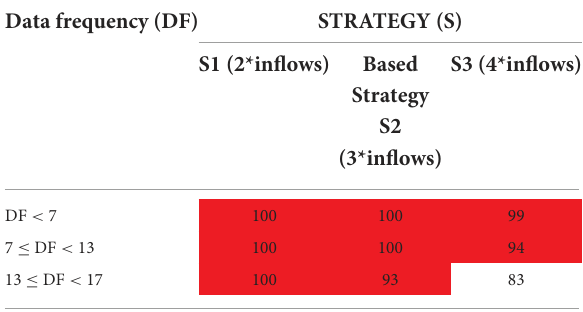
The red color indicates or marks probabilities above or equal to 90% for each frequency andstrategycombination.